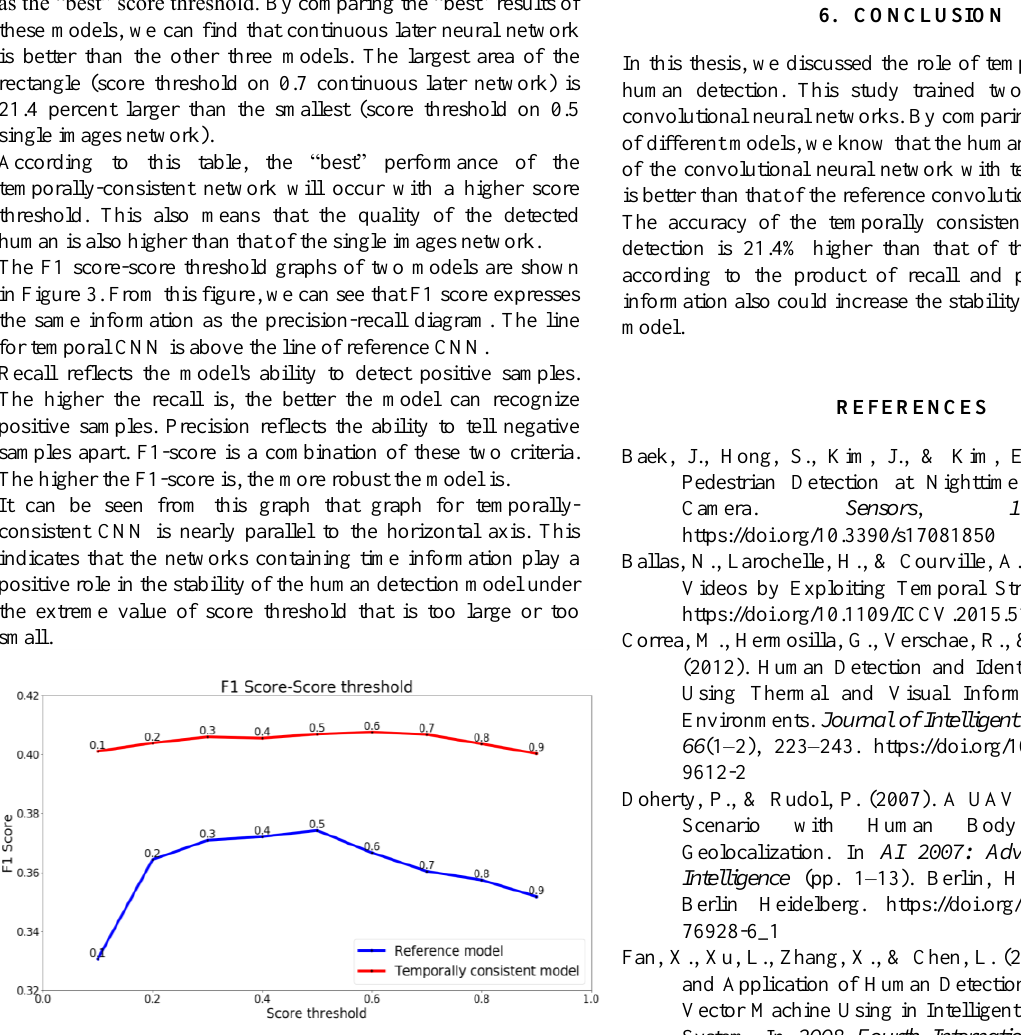
Figure 3 The F1 score- score threshold graph of two models.